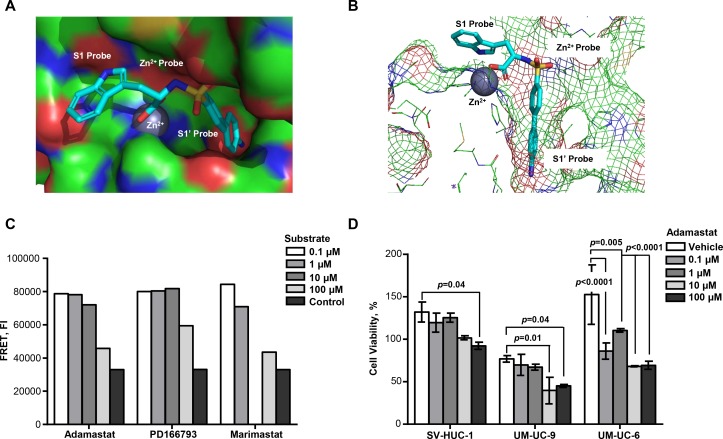
Novel ADAM15-specific sulfonamide inhibitor reduces viability of bladder cancer cells.A) Surface model of adamastat binding to the ADAM15 catalytic. B) A mesh representation of adamastat binding in the S1’ pocket of the catalybtic domain of ADAM15. C) Fluorescence Resonance Energy Transfer assay indicating that inhibition of the recombinant ADAM15 catalytic domain (rA15cat) by adamastat is as effective as two other previously tested metalloproteinase inhibitors over the same concentration range. FI, Fluorescence Intensity. D) Viability of adamastat treated SV-HUC-1, UM-UC-9 and UM-UC-6 cells. Vehicle represents 0.1% DMSO control. Bars show mean cell viability % ± SD in 1 out of three independent experiments.